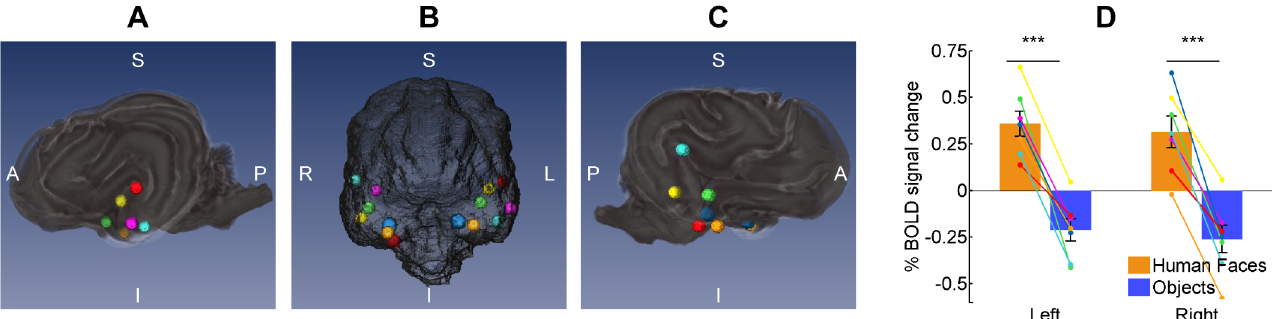
Fig 5. Location of the most sensitive region for faces in each participant in the temporal cortex. A-C: Left lateral, anterior and right lateral views showing spheres of 5 mm radius in each hemisphere, colored differently for each dog. D: BOLD signal change in both hemispheres in response to faces and objects within the sphere of each participant. Lines represent the data of each dog, colors according to spheres in A-C. Vertical lines represent the standard error ( *** < 0.001).